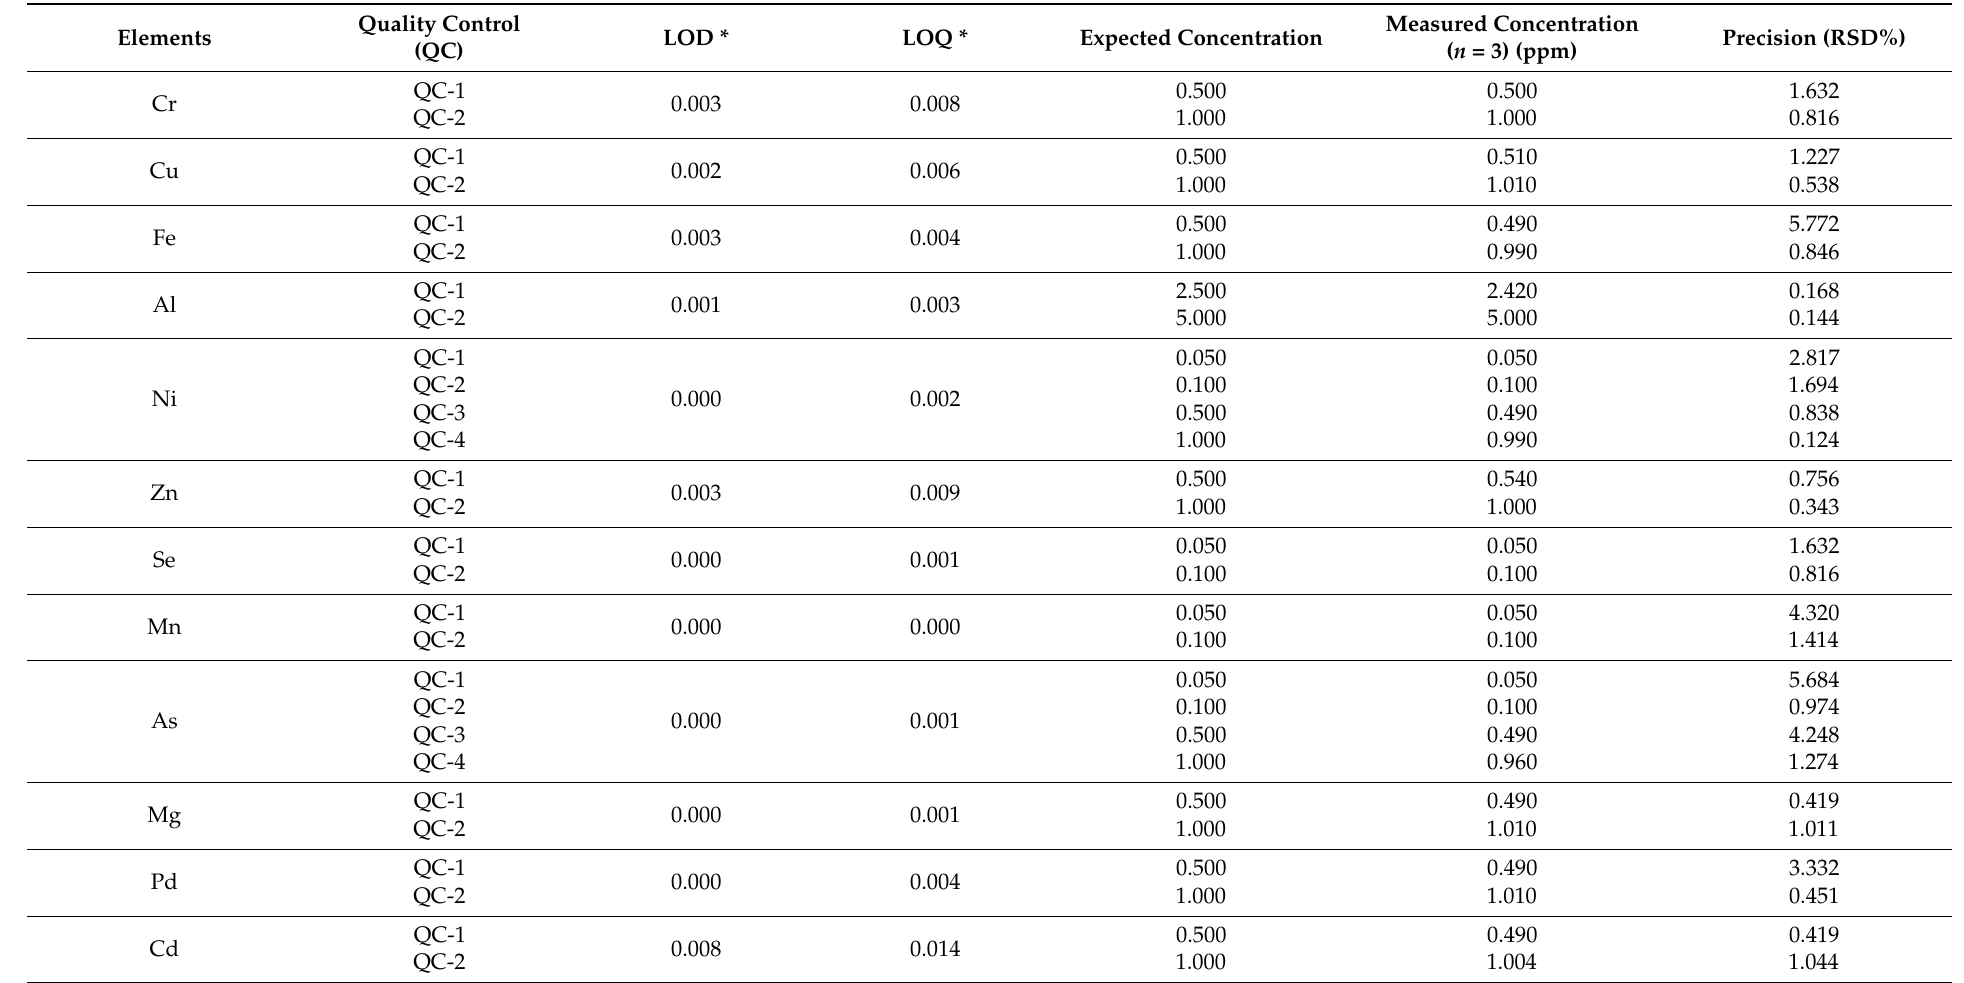
Table 3. The results of ICP-OES method validation for